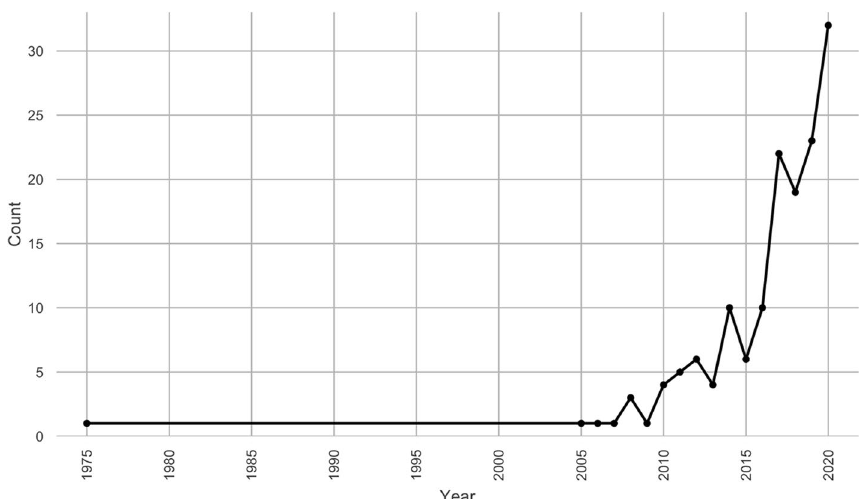
Fig. 3 Network analysis publication